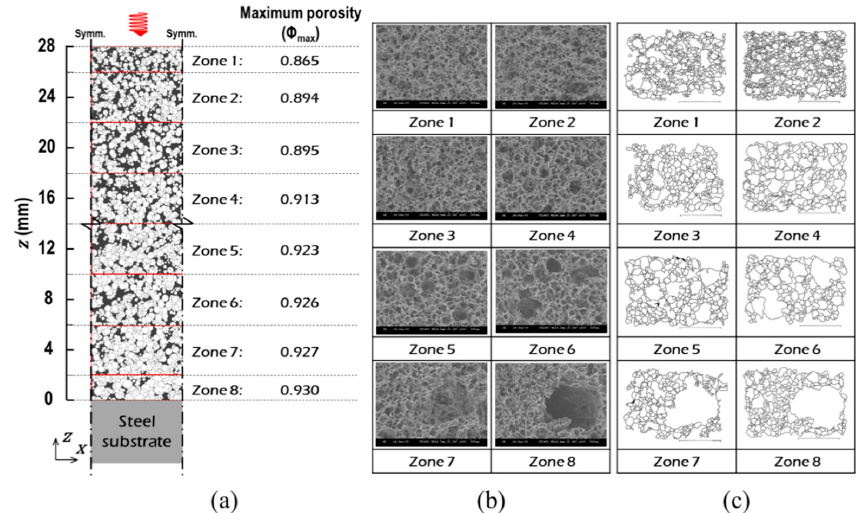
Figure 4. Data obtained from the electric furnace tests: ( a ) schematics of the porosity distribution along the coating thickness, ( b ) the SEM images, and ( c ) the corresponding void boundaries.